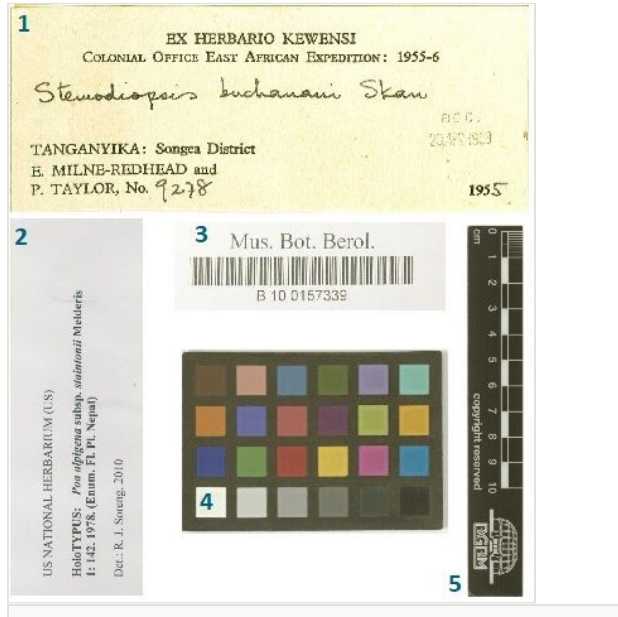
An impression of the different challenges presented by specimen image segments. 1=Label with both printed and handwritten text, 2=Printed label placed non-horizontally, 3=Barcode composed of unhelpful characters, 4=Colour chart containing no text, 5=Ruler containing no useful